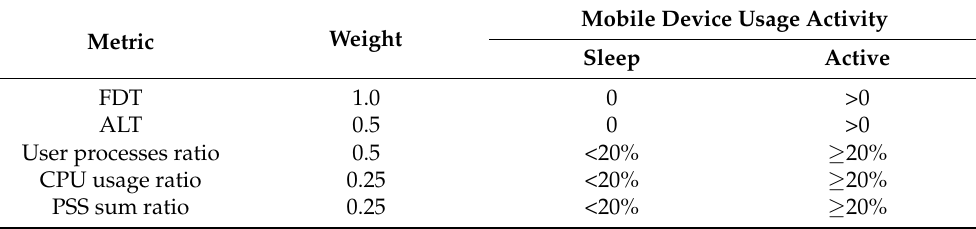
Table 2. Metrics and their thresholds for determining the usage activity level of mobile devices.